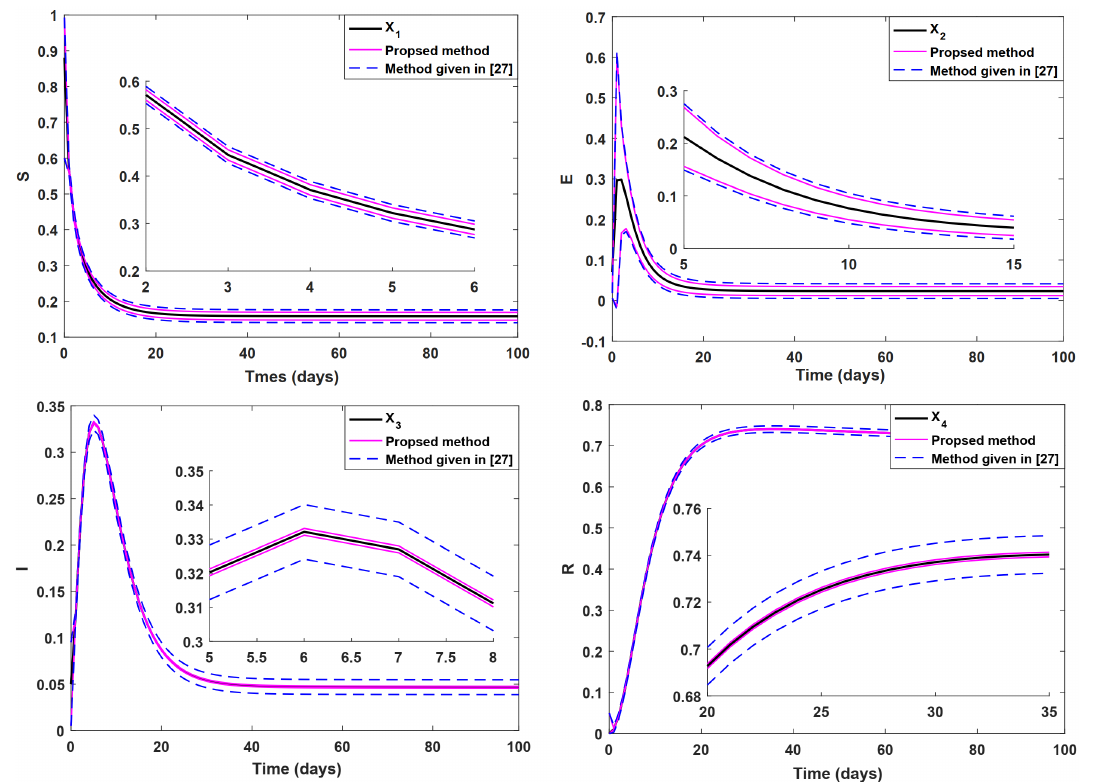
Figure 6. Interval estimations by proposed method vs. the method given in [27] for each state variable x 1 , x 2 , x 3 , x 4 corresponding to S , E , I , R .